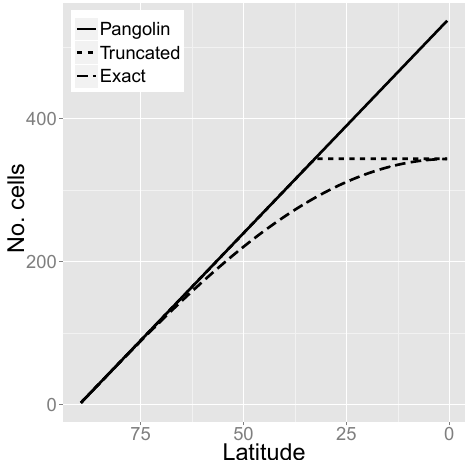
Figure 3. Number of cells for the grid used by Pangolin on one hemisphere with 90 latitudes (solid line). The truncated and “exact” version are shown as dotted and dashed lines, respectively.